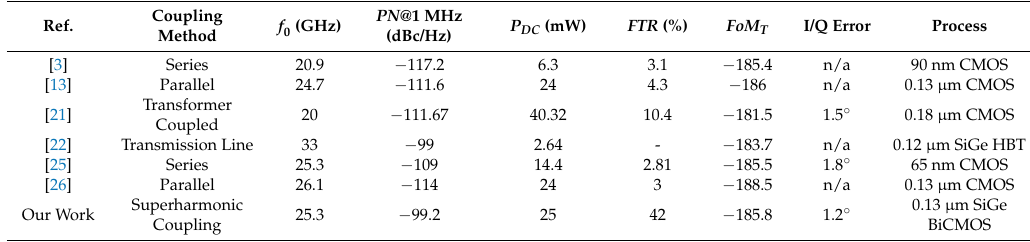
Table 2. Comparison of reported K / K a band QVCOs and this